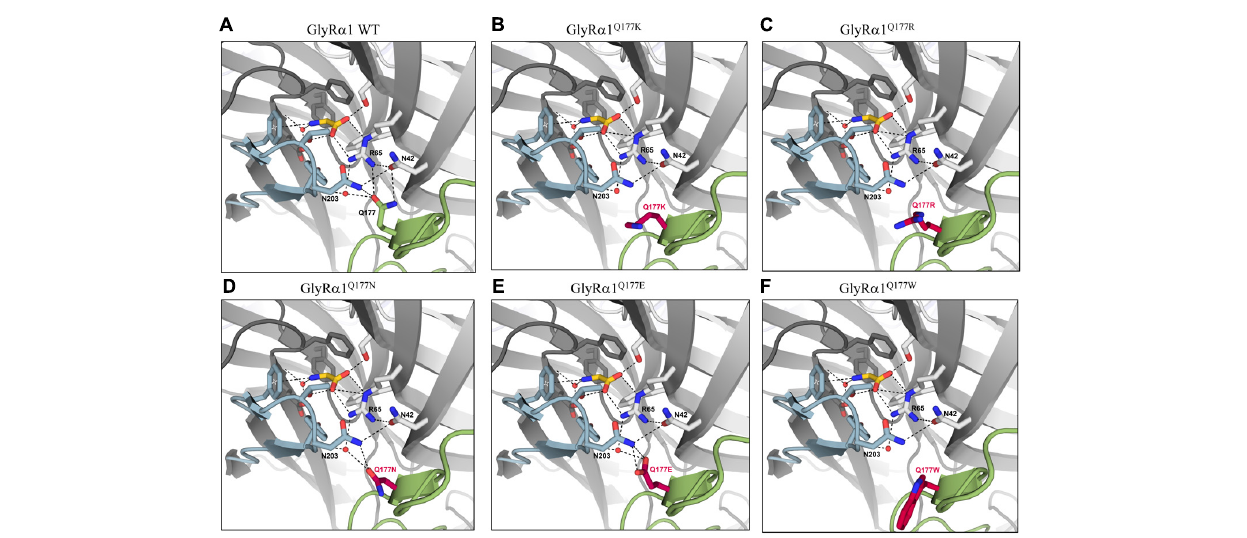
FIGURE 6 | Q177 is localized in a hydrogen bond network important for GlyR function. Q177 is part of a hydrogen-bond network with R65, a critical residue in glycine binding. View into the ligand binding site in the crystal structure of GlyR α 3 in complex with AM-3607 and glycine ((Huang et al., 2017) PDB code 5TIN). The principal and complementary subunits are colored gray, respectively. The agonist glycine is shown in yellow, residues that form the ligand binding pocket are marked in blue, Q177 in green or modeled variants (A) GlyR α 1 WT, (B) GlyR α 1 Q177K , (C) GlyR α 1 Q177R , (D) GlyR α 1 Q177N , (E) GlyR α 1 Q177E , and (F) GlyR α 1 Q177W at this position in red. Loops C and β 8– β 9 are marked in light blue (loop C) and light green ( β 8– β 9). Residues that are engaged in the hydrogen bond network are shown as sticks, relevant water molecules are represented as spheres. Hydrogen bonds (to max. distance of 3.3 Å) are indicated as black dashed